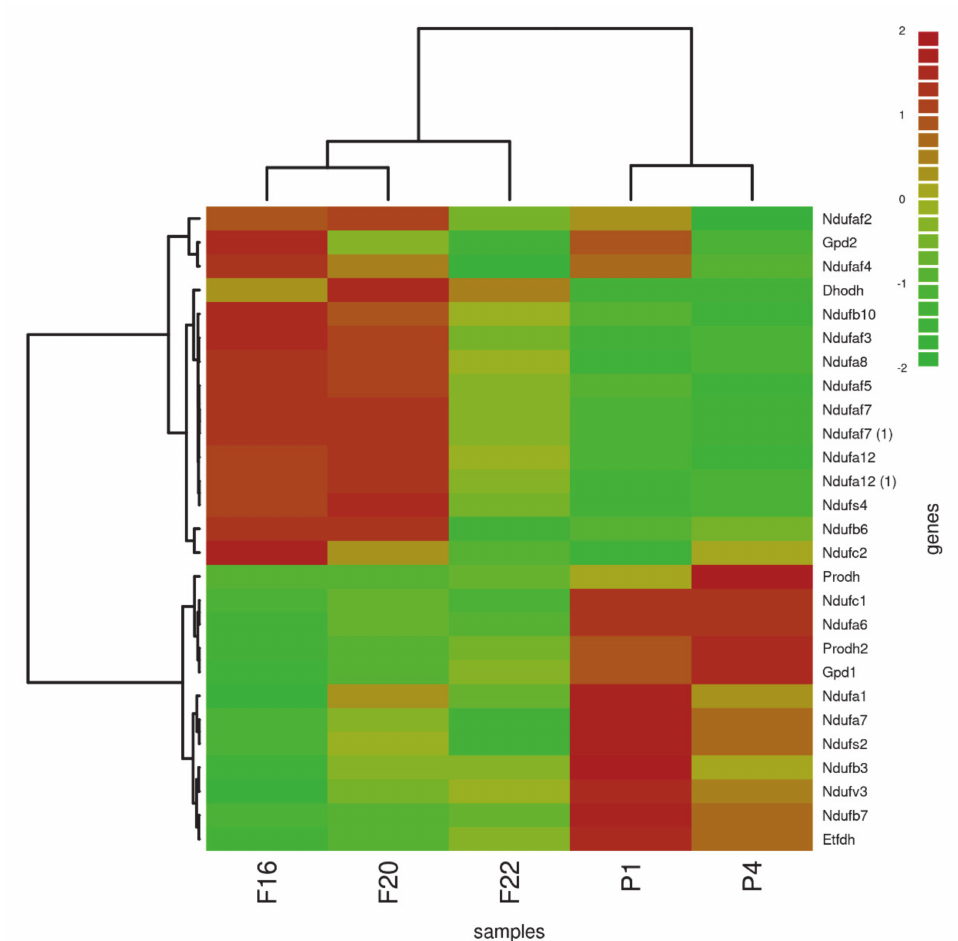
Figure A2. Liver-specific changes in the expression of genes coding selected enzymes involved in CoQ metabolism and function. Changes in expression of genes coding complex I (including assembly factors; Nduf ), proline dehydrogenase ( Prodh ), glycerol-3-phosphate dehydrogenase ( Gpd ), electron-transferring-flavoprotein dehydrogenase ( Etf ) and dihydrooro- tate dehydrogenase (quinone; Dhodh ) were analysed in rat tissues. In the rat liver, the expression of all genes included in the heatmap changed significantly ( p ≤ 0.05, betr package). Average values from 4 biological replicates were used. Data were transposed and auto-scaled in GenEx (MultiD Analyzes AB, Göteborg, Sweden). Ward’s algorithm was chosen as a clustering method according to Pearson’s correlation coefficient distance to construct the heatmap in R ("R Core Team" URL: http://www.r-project.org/ accessed on 3 May 2021). For Ndufaf7 and Ndufa12 , there were two probes on the array (marked with (1)). In skeletal muscle, only expression of Ndufaf7 and Ndufb6 was significantly decreased after birth; no other changes were detected among genes clustered in Figure A2 (not shown). F—Foetal day, P—Postnatal